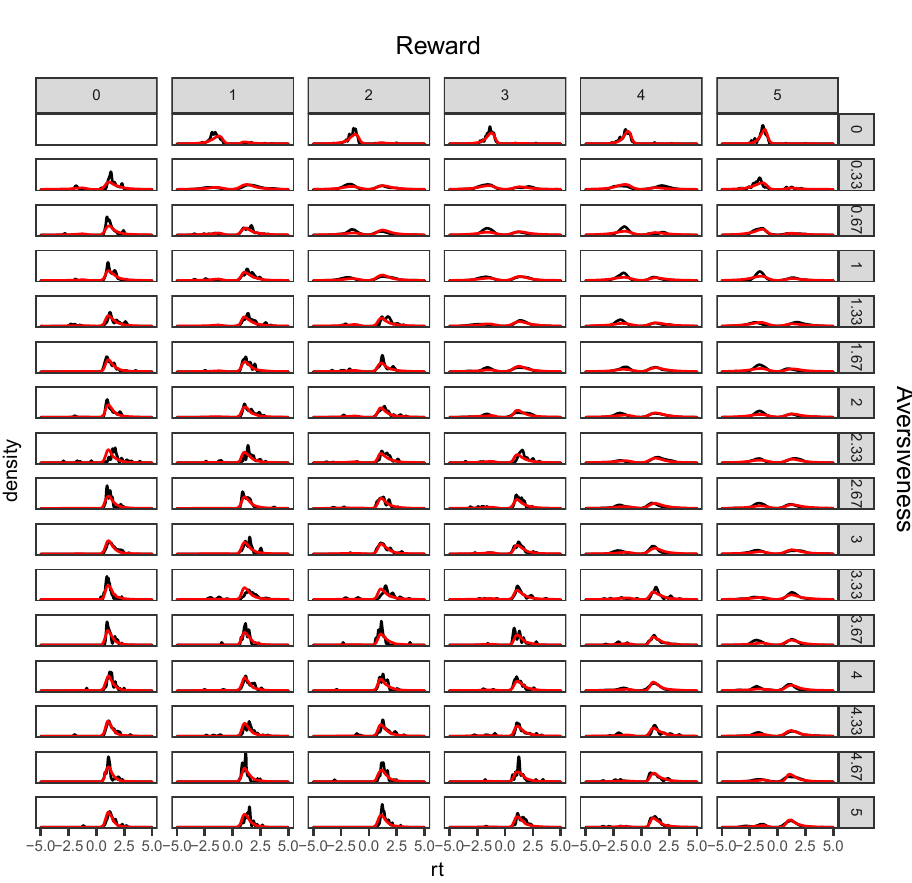
Fig 2. Posterior predictive check. The figure illustrates the models’ (red lines) ability to recreate observed (black lines) choice and response time distributions across all combinations of offered reward and aversiveness. Avoidance decisions are set to have negative response times to distinguish the reaction time distribution of decisions to approach and avoid offers and to indicate the relative proportion of (observed and predicted) approach and avoidance decisions across combinations of reward and